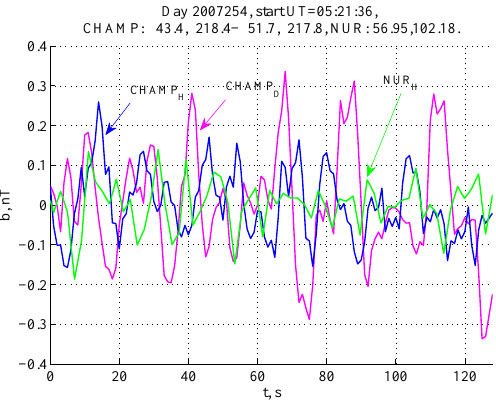
f L = 20mHz) magnetograms for the CHAMP horizontal ( b H and b D ) components and the ground b H registered at the NUR station for the 128s interval starting at 05:21:36UT on day 2007254. CHAMP latitude and longitude val- ues in CGM coordinates at the start and end of the interval shown and NUR CGM coordinates are given in the figure